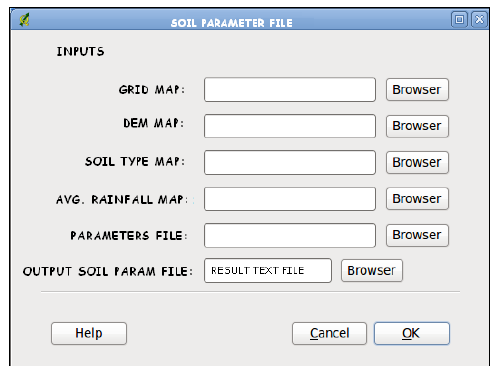
Figure 5 User Interface to generate Soil Parameter